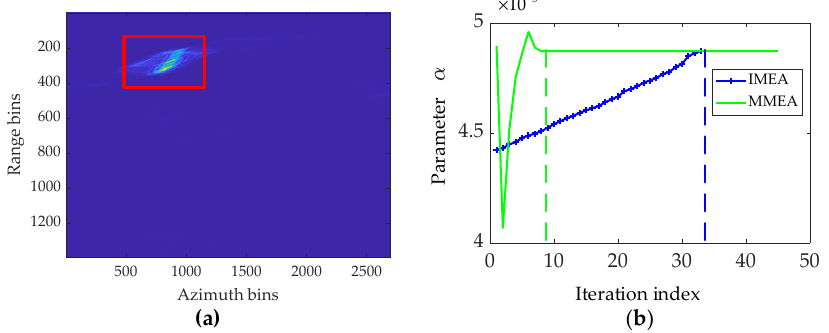
Figure 13. ( a ) Conventional RMA imaging results of ship target; ( b ) The GMT parameter iteration graph of MMEA and IMEA.